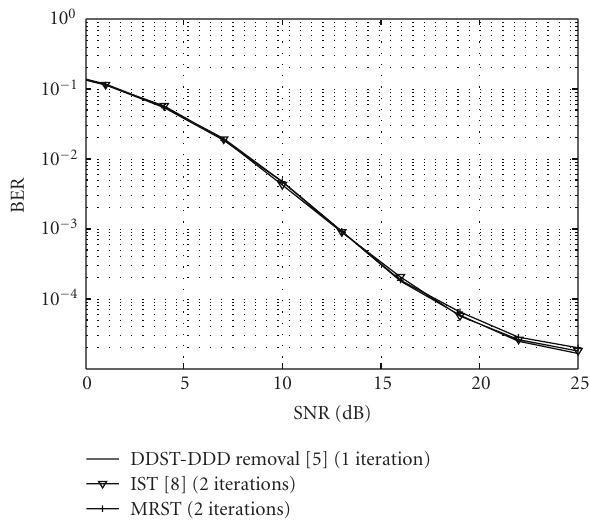
Figure 4: BER performance of BPSK signals with MMSE equalizer.